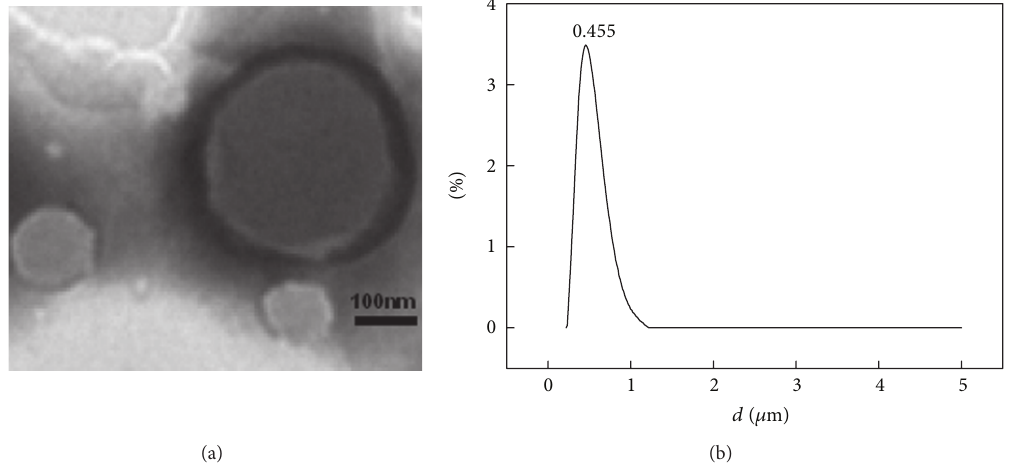
Figure 3: (a) TEM graph and (b) diameter distribution of the synthesized